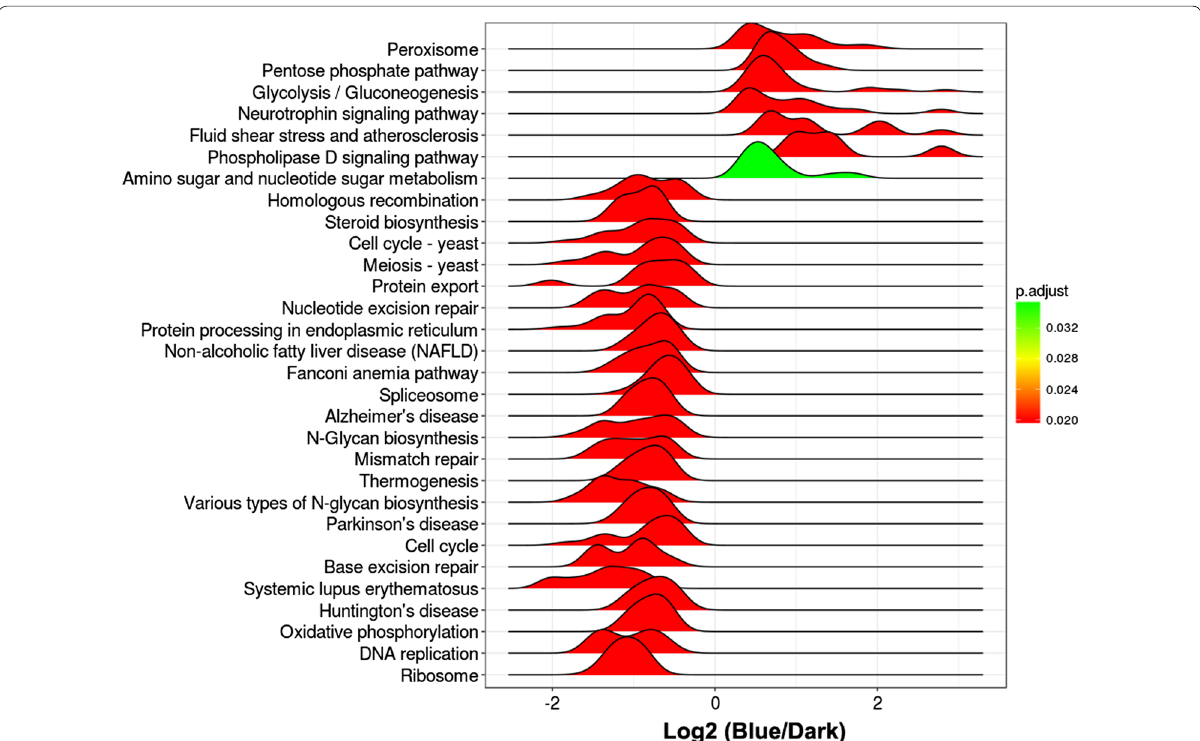
Fig. 2 KEGG enrichment of different gene expressions in the pileus between blue-light treatment and dark treatment. Fold changes (blue-light/ dark) of all the expressed genes were subjected to GSEA-KEGG